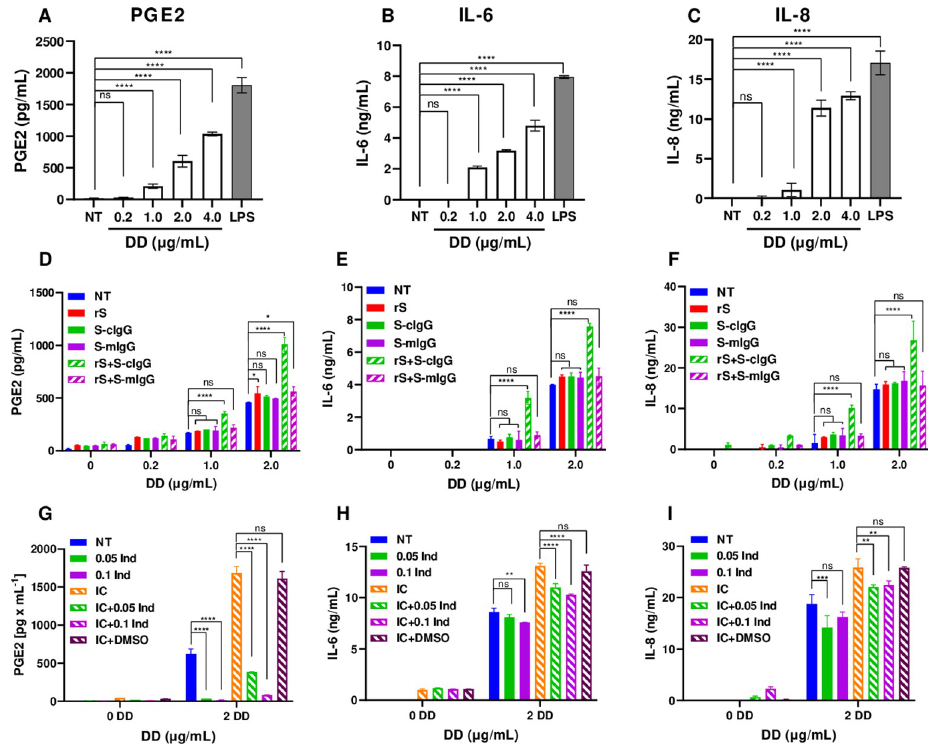
Fig 1. Production of PGE2, IL-6, and IL-8 in monocytes activated with DD in the presence of IC of SARS-CoV-2 rS protein with anti-CoV-2 spike MAb. Production of PGE2, IL-6, and IL-8 cytokines in monocytes activated with DD alone (A-C), with DD and IC (D-F), or with DD and IC in the presence of inhibitor of COX-2, indomethacin (G-I). Monocytes were left not treated (NT, A-I) or were incubated with DD or with LPS at 100 ng/ml (A-C) or with DD in the presence of rS, S-cIgG, S-mIgG, or IC of rS+S-cIgG or rS+S-mIgG (D-F) overnight. Monocytes were incubated with DD alone or with DD and rS+S-cIgG IC (IC) alone or in the presence of indomethacin (Ind at 0.05 or 0.1 μ M) or with DMSO (G-I). Cell culture supernatants were collected and PGE2 (A, D, and G), IL-6 (B, E, and H) and IL-8 (C, F, and I) concentrations were determined by FRET assay (A, B) and by ELISA (B, C, E, F). Mean PGE2 and IL-6, and IL-8 concentrations ± SD calculated for triplicate wells are shown for a representative of three experiments performed with cells from individual donors. ���� P � 0.0001, by one-way ANOVA with Sidak’s multiple comparison test (A-C), and � P � 0.05, ���� P � 0.0001 by two-way ANOVA using Tukey’s multiple comparison test